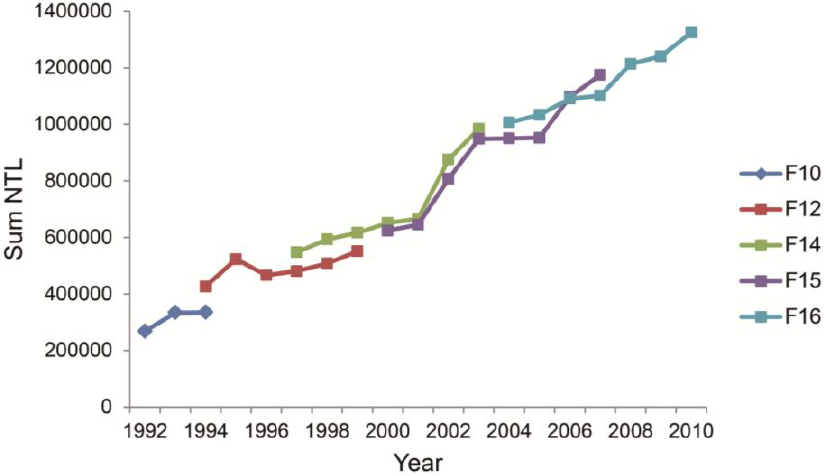
Figure 4. Inter-calibrated sum of DMSP/OLS nighttime lights of ZJP during 1992–2010 from different satellites. Each satellite is designated with a flight number, such as F10 for DMSP satellite number 10.